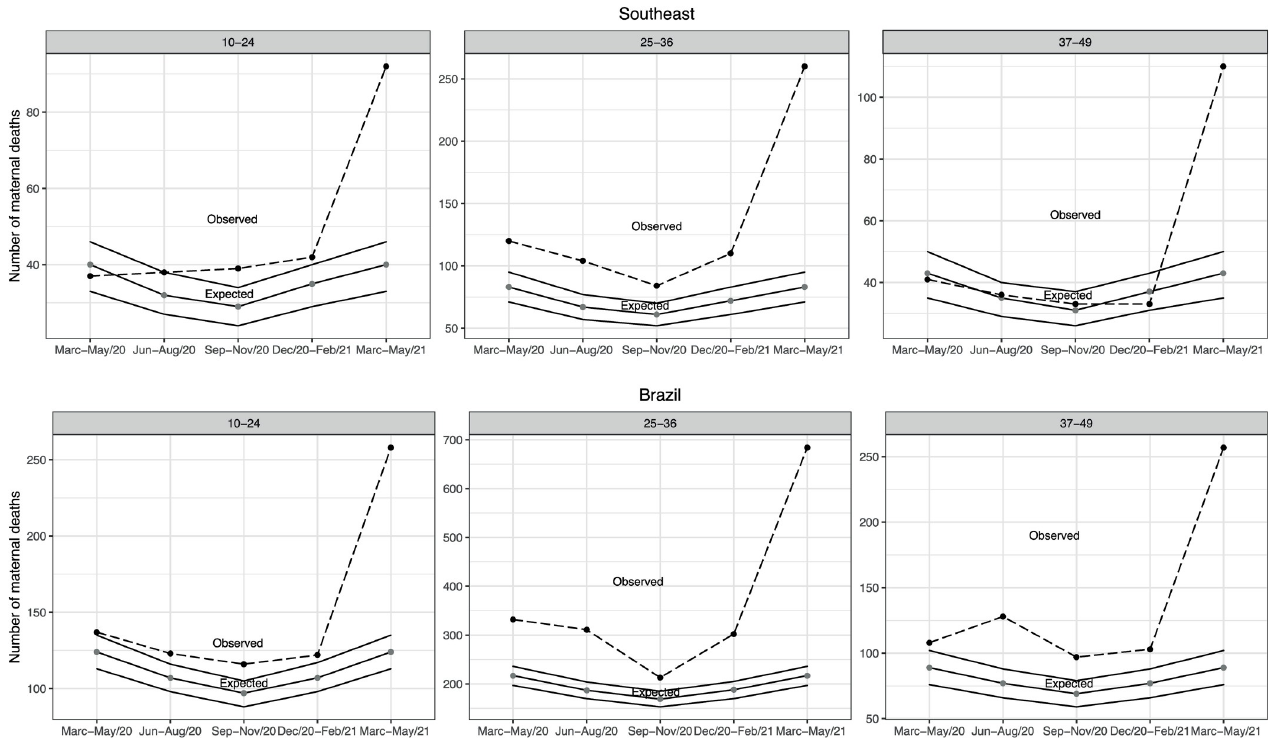
Fig 3. Observed and expected maternal deaths according to age group and five consecutive trimonthly periods, Southeast region and Brazil, 2020–2021.